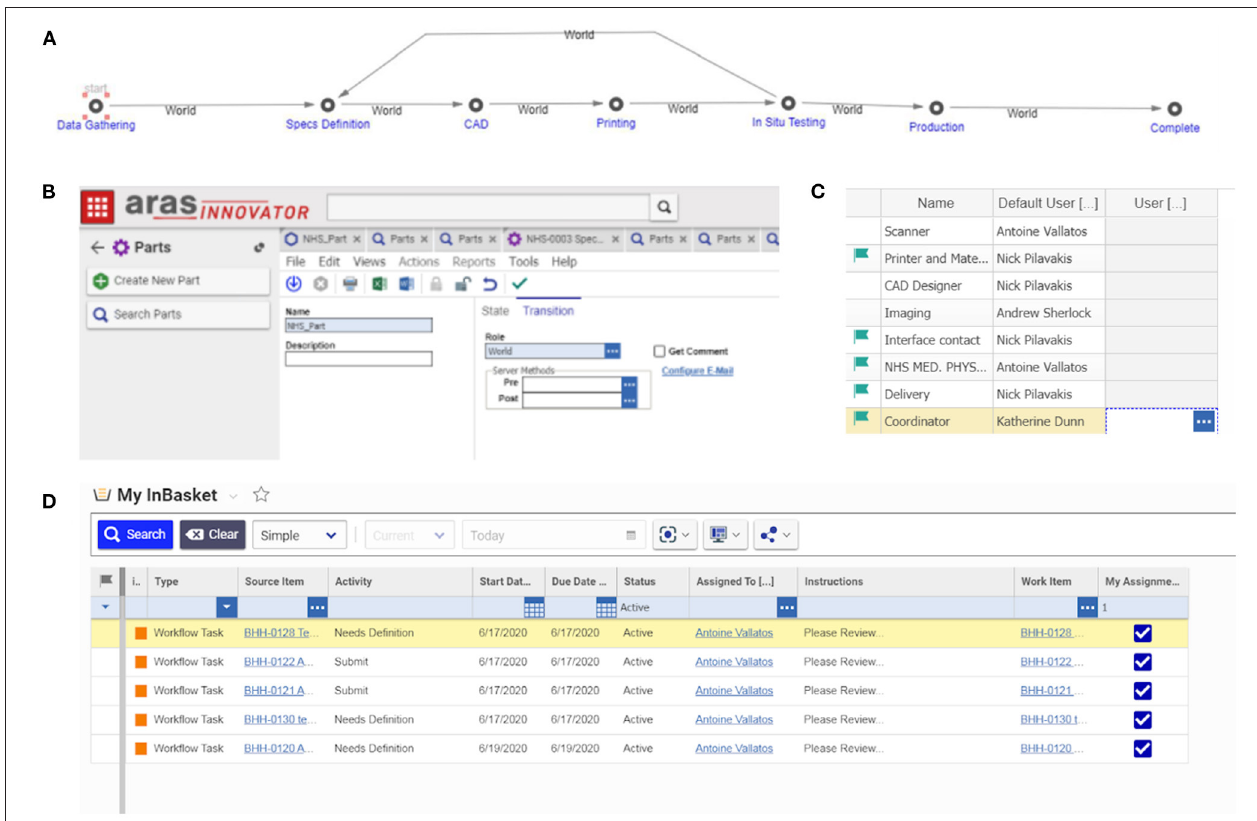
FIGURE 13 | PLM implementation into Aras Innovator – a platform for the coordination of bespoke medical equipment: (A) the PLM stages in Aras, each stage requires a number of tasks to be accomplished and documents to be produced; (B) each new job begins with the start of a new PLM life cycle; (C) roles are assigned to contacts; (D) the software advances through the life stages informing people of the tasks they have to accomplish automatically, either on the online platform or by